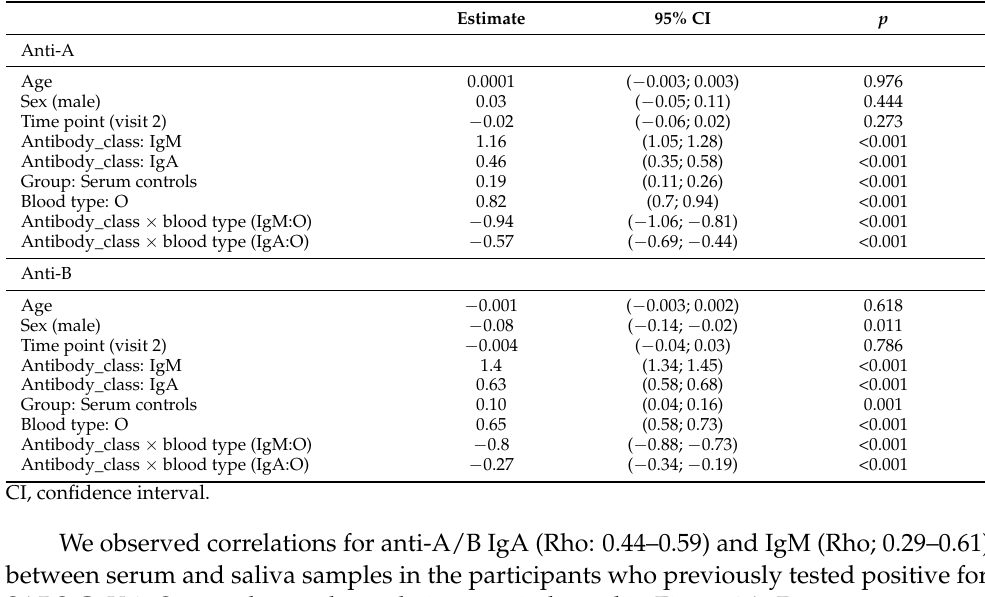
Table 3. Results of linear mixed effects models for anti-A and anti-B in the serum of COVID-19 convalescents versus controls.